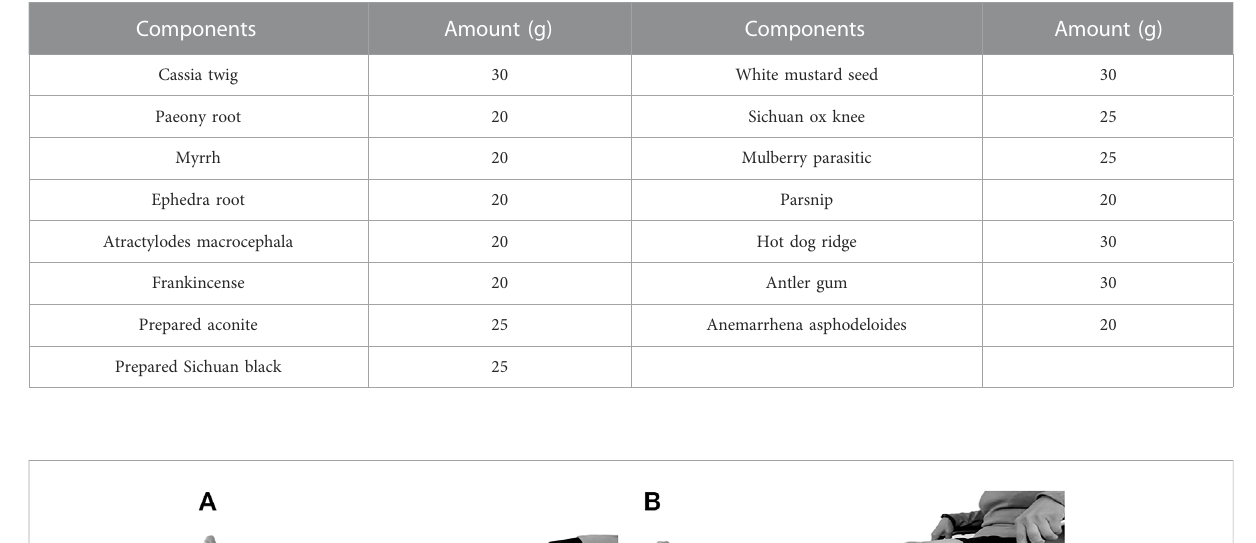
TABLE 1 Components of Traditional Chinese herbs.